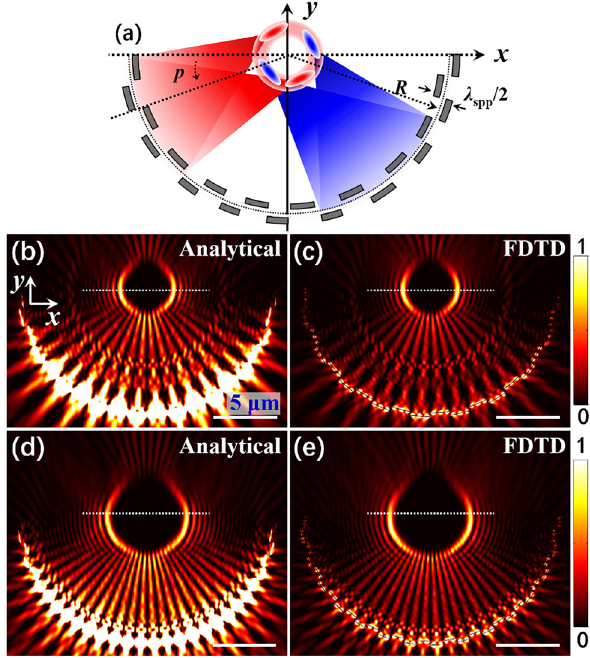
Figure 3: Generation of SPP bottle beam by proposed metalens. (a) Schematic diagram of the principle of synthesizing SPP bottle beam. The radius of the reference arc (black dotted curve line) is R = 10 μ m, and the distance between two adjacent arc slits in the radial direction is λ spp /2. (b) – (e) Intensity distribution of the SPP bottlebeam.(b)and(c) α =180 ° , p =18 ° ,(d)and(e) α =180 ° , p =12 ° . (b) and (d) are analytical results. (c) and (e) are FDTD simulation results. All other parameters are as in Figure